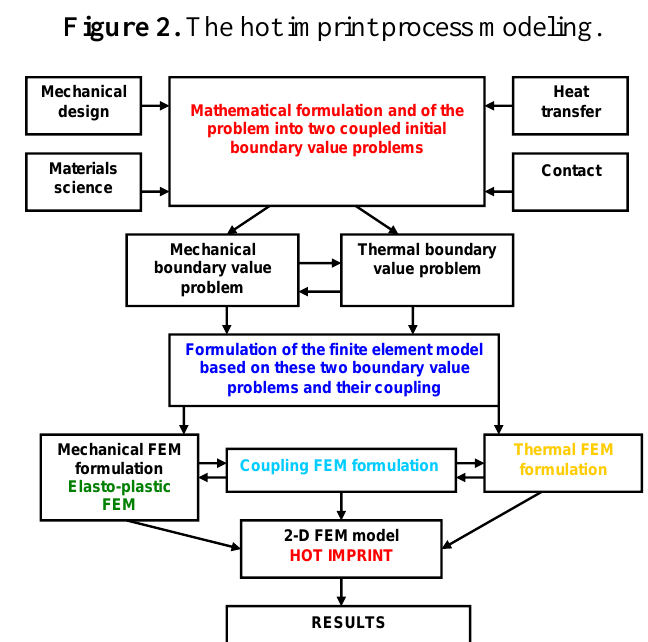
Figure 2. The hot imprint process